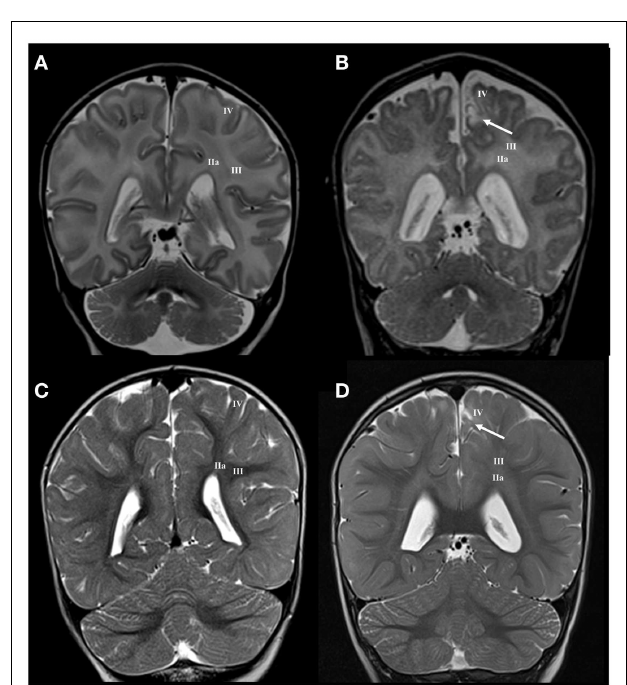
FIGURE 4 | Longitudinal MRI follow-up of centrum semiovale perinatal lesion on coronalT2 images . Normal findings of centrum semiovale at term age (A) with visible border between parietal crossroad and centrum semiovale [arrow in (A) ]. Normal findings at the age of 13months with barely visible border between U-fibers and centrum semiovale [arrow in (C) ].Term born child (BW = 3960g, SNAPII = 40, SNAPPEII = 58, AS = 0/4) with perinatal asphyxia and diffuse hyperintensity of white matter with diminished border between parietal crossroad and centrum semiovale at term equivalent age [arrow in (B) ] but with enhanced visibility of border between U-fibers and hyper-intensive centrum semiovale at the age of 13months [arrows in (D) ]. Numbers I–IV represent segments of white matter as previously described.